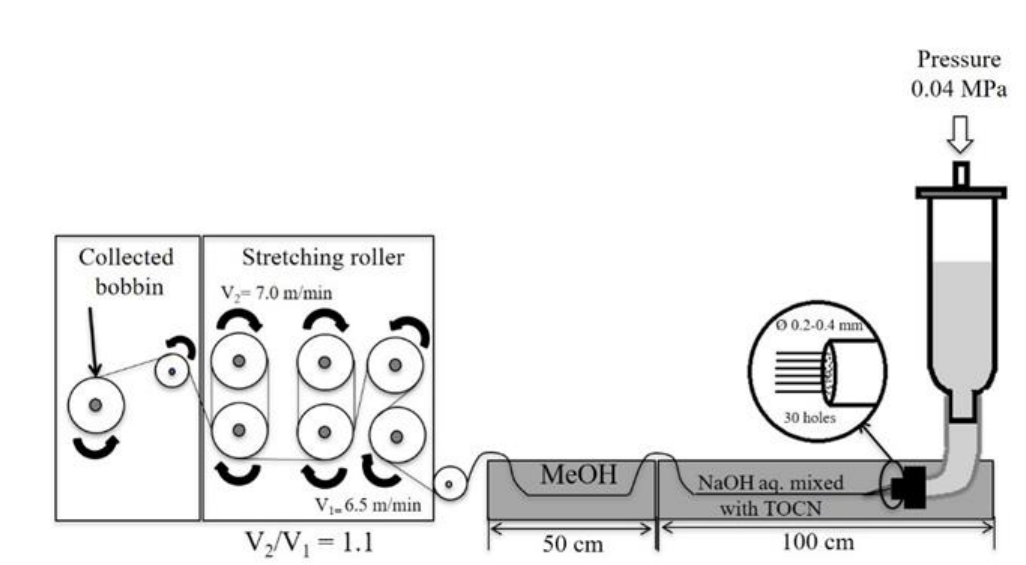
Figure 1. Wet-spinning apparatus and spinning conditions.